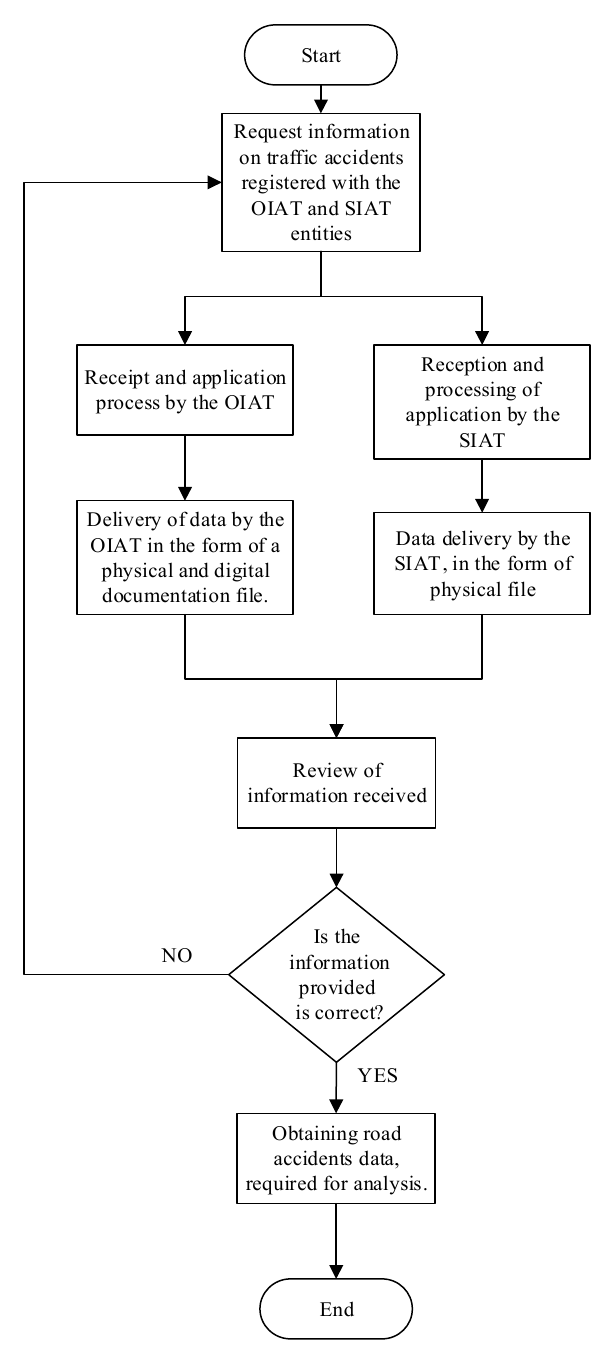
Figure 2. The process to obtain the data regarding road crashes.